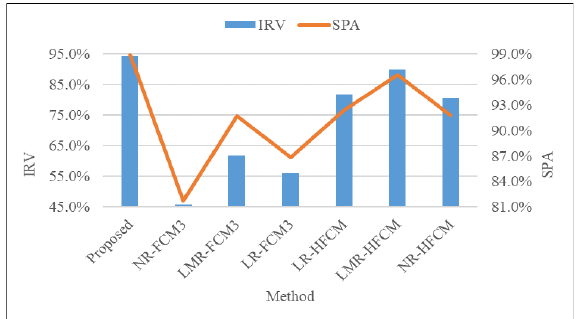
Figure 10. ICV and SA of various sample selection methods on Yamenkou dataset.